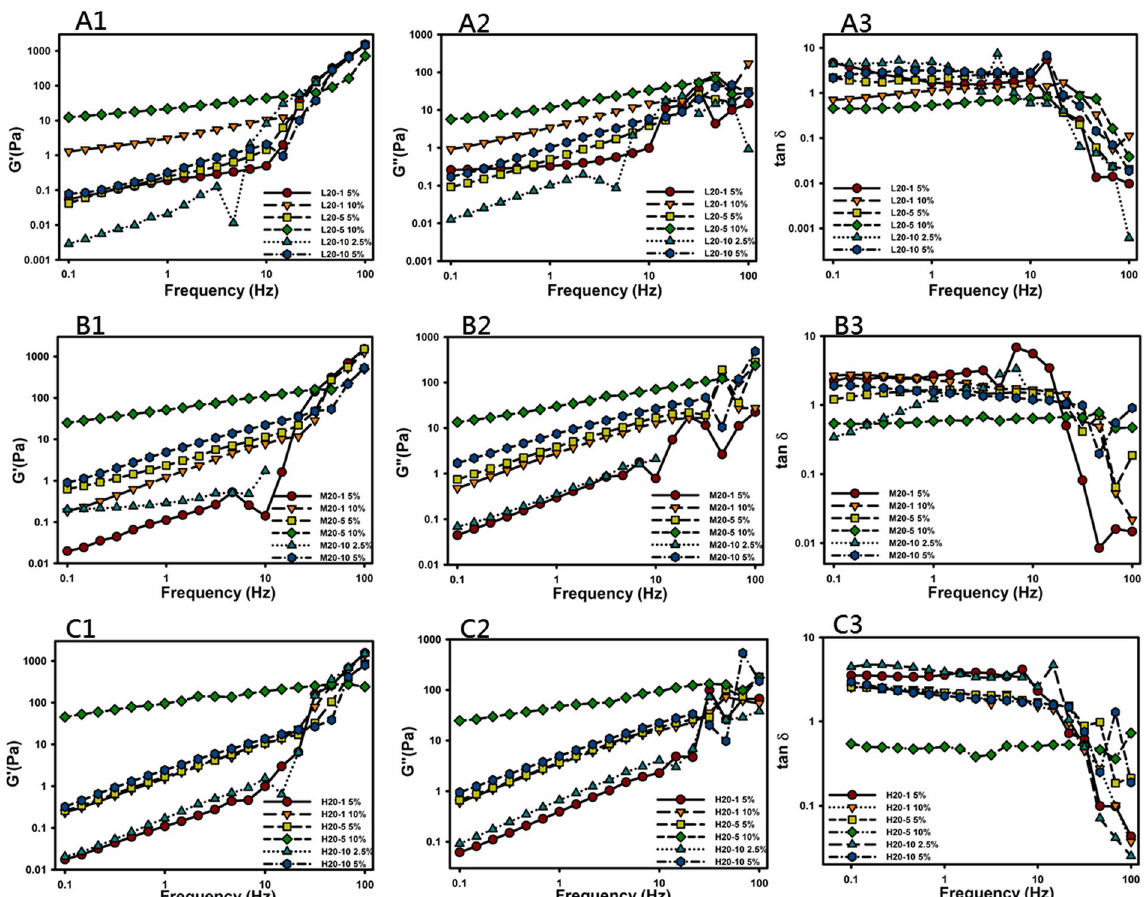
Figure 3. Frequency sweeps of ring-opened polyvinyl pyrrolidone ( ro PVP)/chitosan (CS) hydrogels composed of ro PVP complexed with CS of low (L), medium (M), and high (H) molecular weights (Mws) at various ratios of 20:1, 20:5, and 20:10. ( A1 ) L20:1; ( A2 ) L20:5; ( A3 ) L20:10; ( B1 ) M20:1; ( B2 ) M20:5; ( B3 ) M20:10; ( C1 ) H20:1; ( C2 ) H20:5; ( C3 )